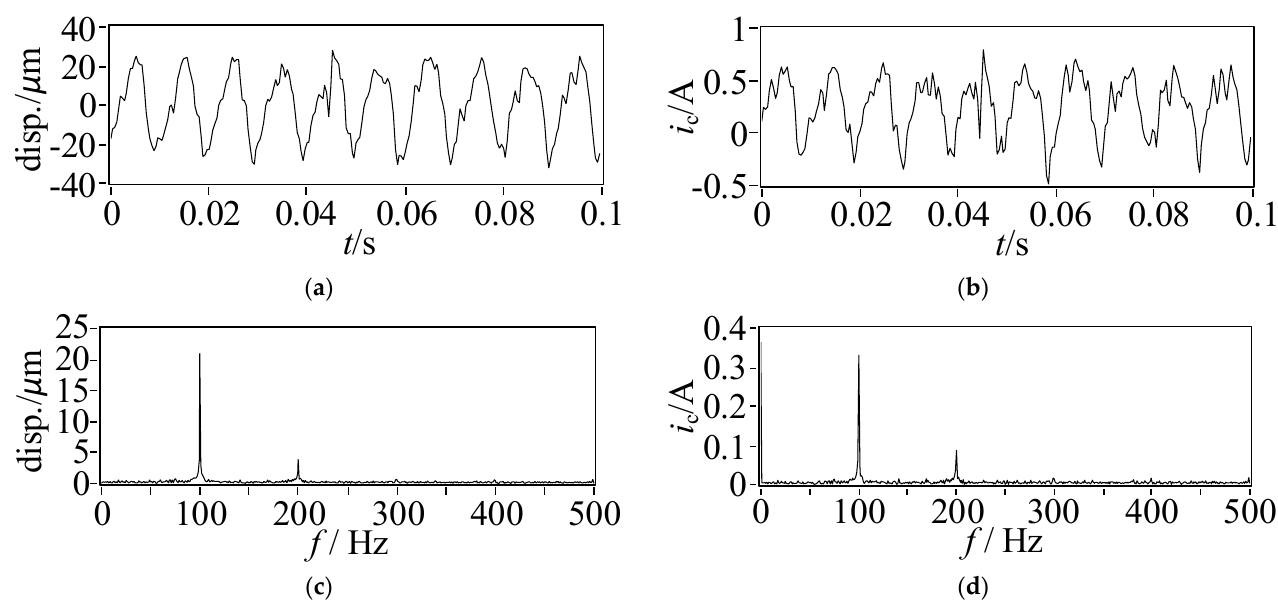
Figure 9. The amplitude-frequency diagram of displacement and current before rotor LMS compen- sation. ( a ) Time domain spectrum of displacement; ( b ) Time domain spectrum of current; ( c ) Frequency spectrum of displacement; ( d ) Frequency spectrum of current.